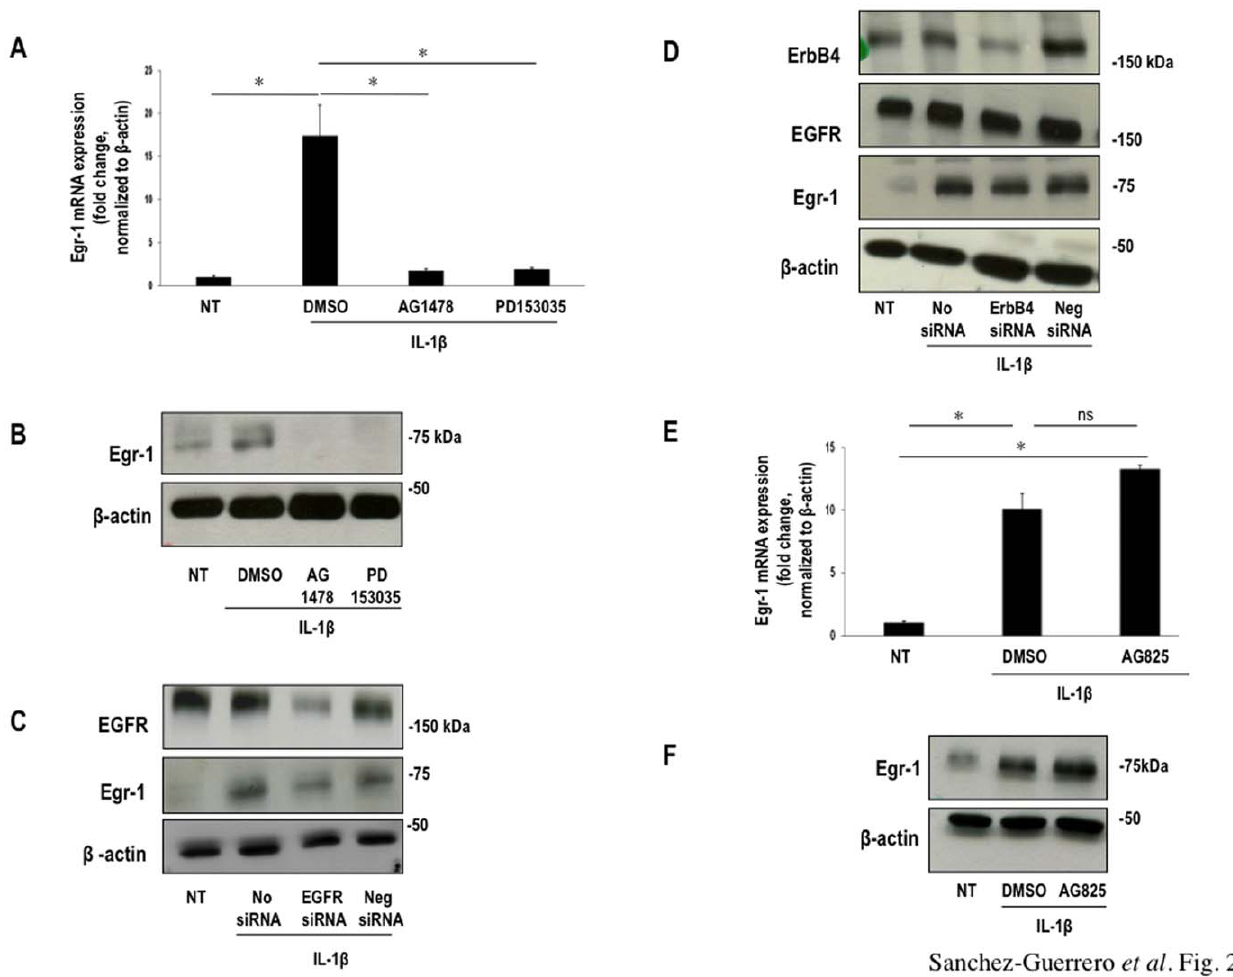
Figure 2. Induction of Egr-1 by IL-1beta is EGFR-dependent. Growth-quiescent SMCs were incubated with EGFR inhibitors AG1478 (5 m M) and PD153035 (5 m M) for 30 min, and exposed to IL-1beta (10 ng/ml) for another 30 min (unless indicated otherwise). ( A ) Egr-1 mRNA levels in AG1478- and PD153035-treated SMCs incubated with IL-1beta by qPCR. Data were normalized to beta-actin. ( B ) Western blotting for Egr-1 or beta-actin of total extracts of SMCs treated with AG1478 or PD153035. ( C ) Western blotting for EGFR, Egr-1 or beta-actin of total extracts of SMCs transfected overnight with EGFR siRNA (0.1 m M) and treated with IL-1beta for 30 min. ( D ) Western blotting for ErbB4, EGFR, Egr-1 or beta-actin of total extracts of SMCs transfected overnight with ErbB4 siRNA (0.1 m M) and treated with IL-1beta for 30 min. ( E ) Egr-1 mRNA levels in AG825 (10 m M for 30 min)- treated SMCs incubated with IL-1beta for 30 min by qPCR. Data were normalized to beta-actin. ( F ) Western blotting for Egr-1 or beta-actin in total extracts of SMCs pretreated with AG825 (10 m M for 30 min) then stimulated with IL-1beta for another 30